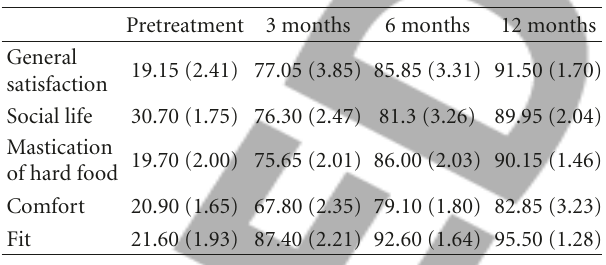
Table 1: Comfort and functional parameters (Means and SDs in mm) at pretreatment and all recall